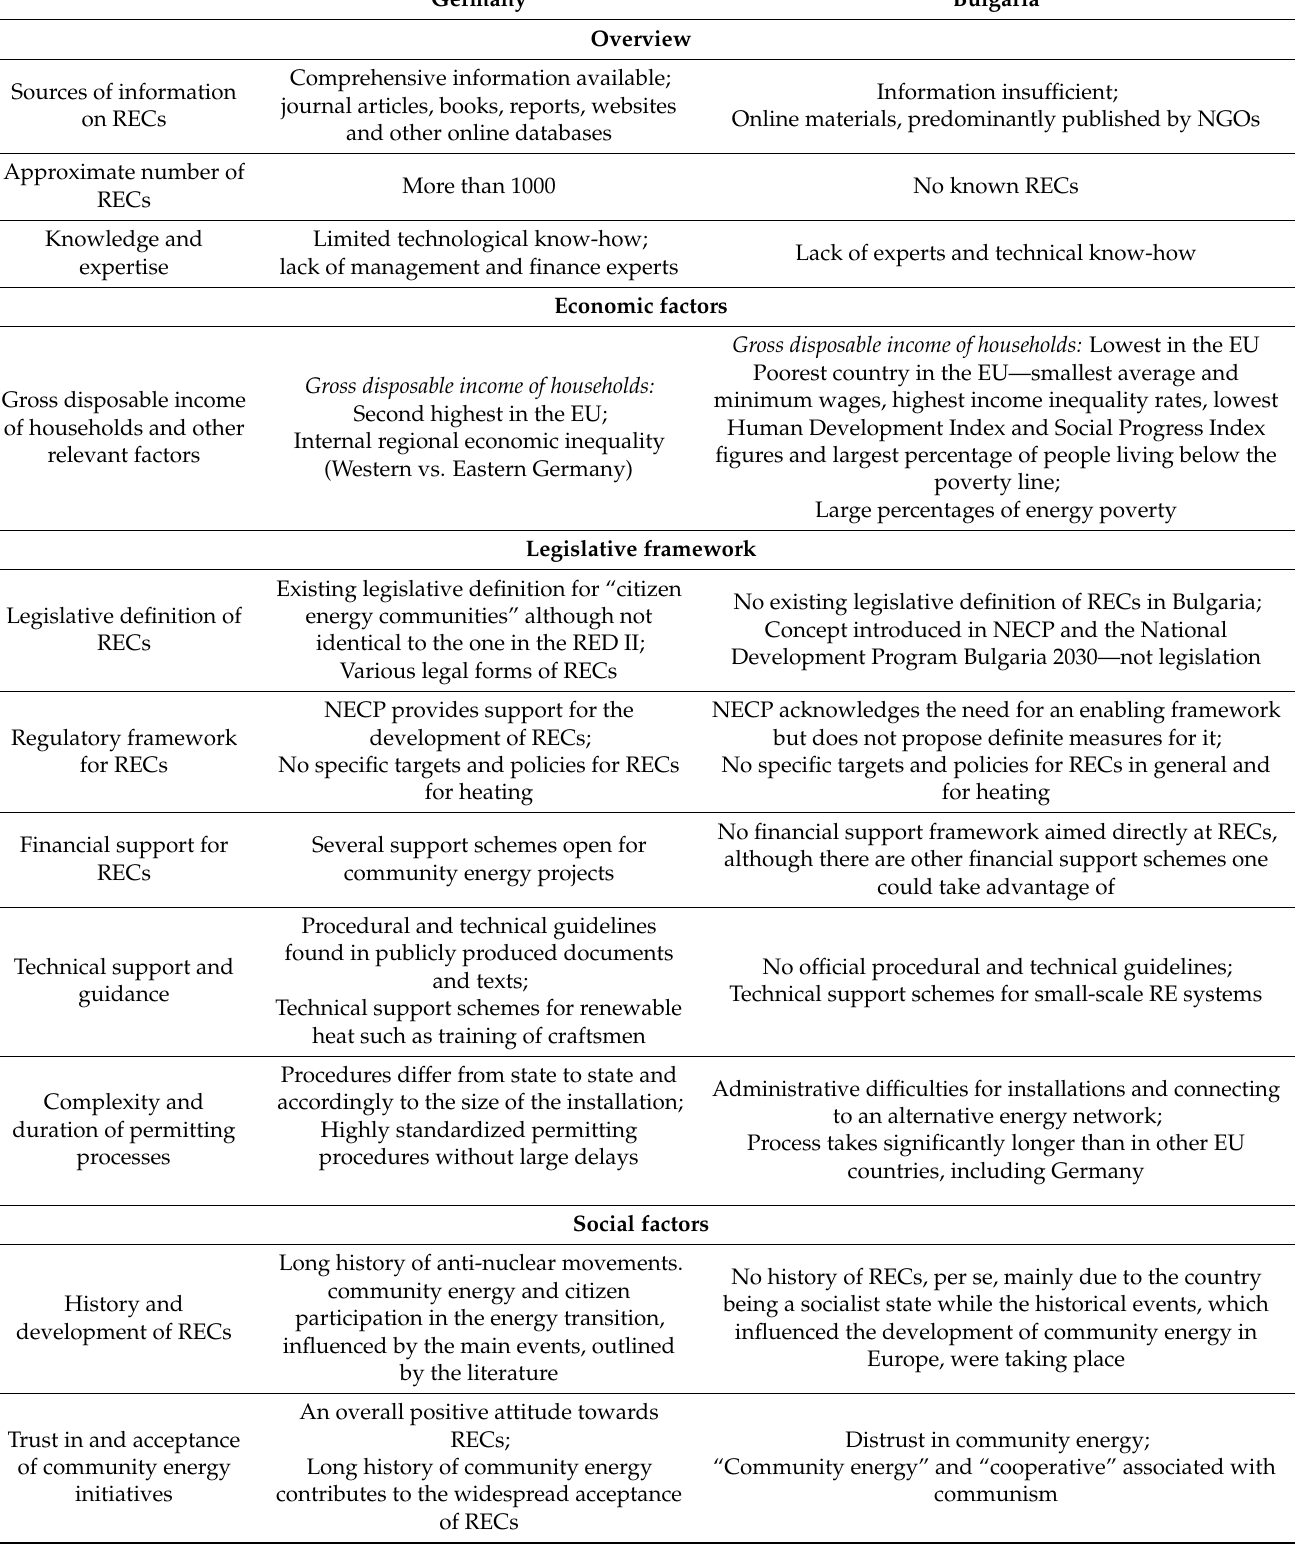
Table 2. A summary of the cross-country comparison of determinants for RECs between Germany and